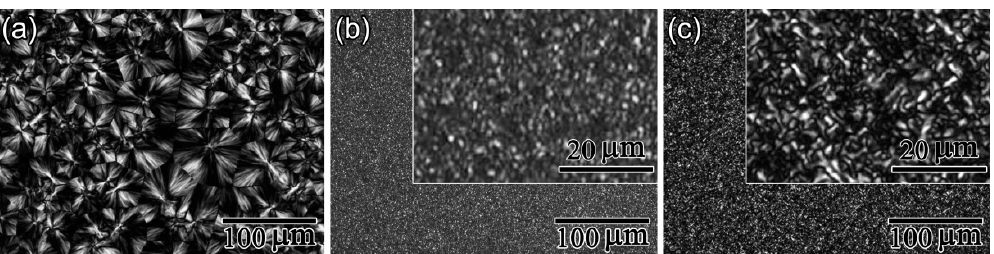
Figure 8. POM micrographs for fully crystallized samples of ( a ) PLA-U; ( b ) PLA-T0; and ( c ) PLA-T35. The insets in panels b – c show high-magnification images.